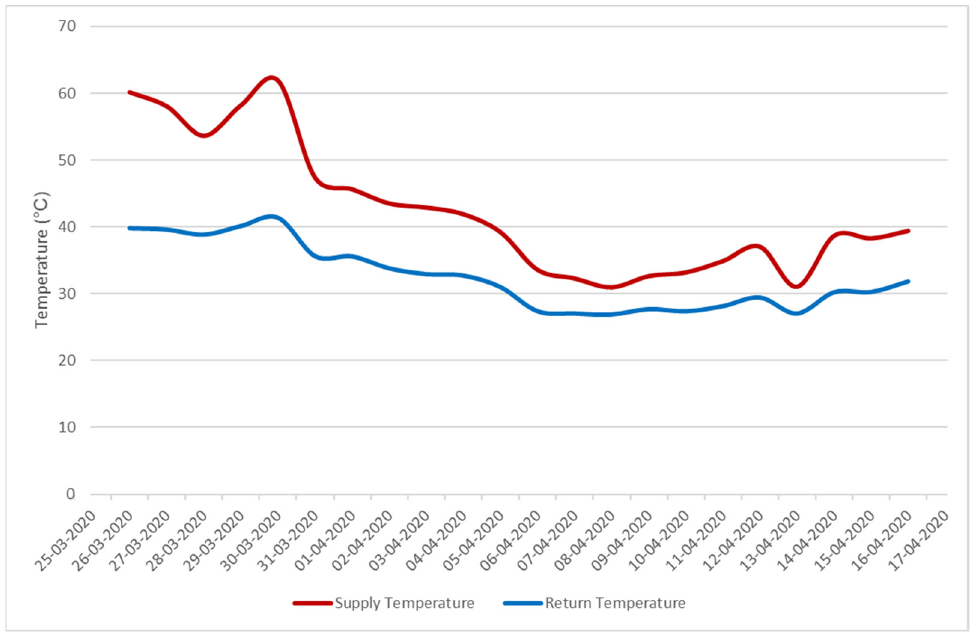
Figure 13. Daily average measurements of supply and return temperatures in the space heating system during the test of prototype 1 in April 2020, where the supply temperature was